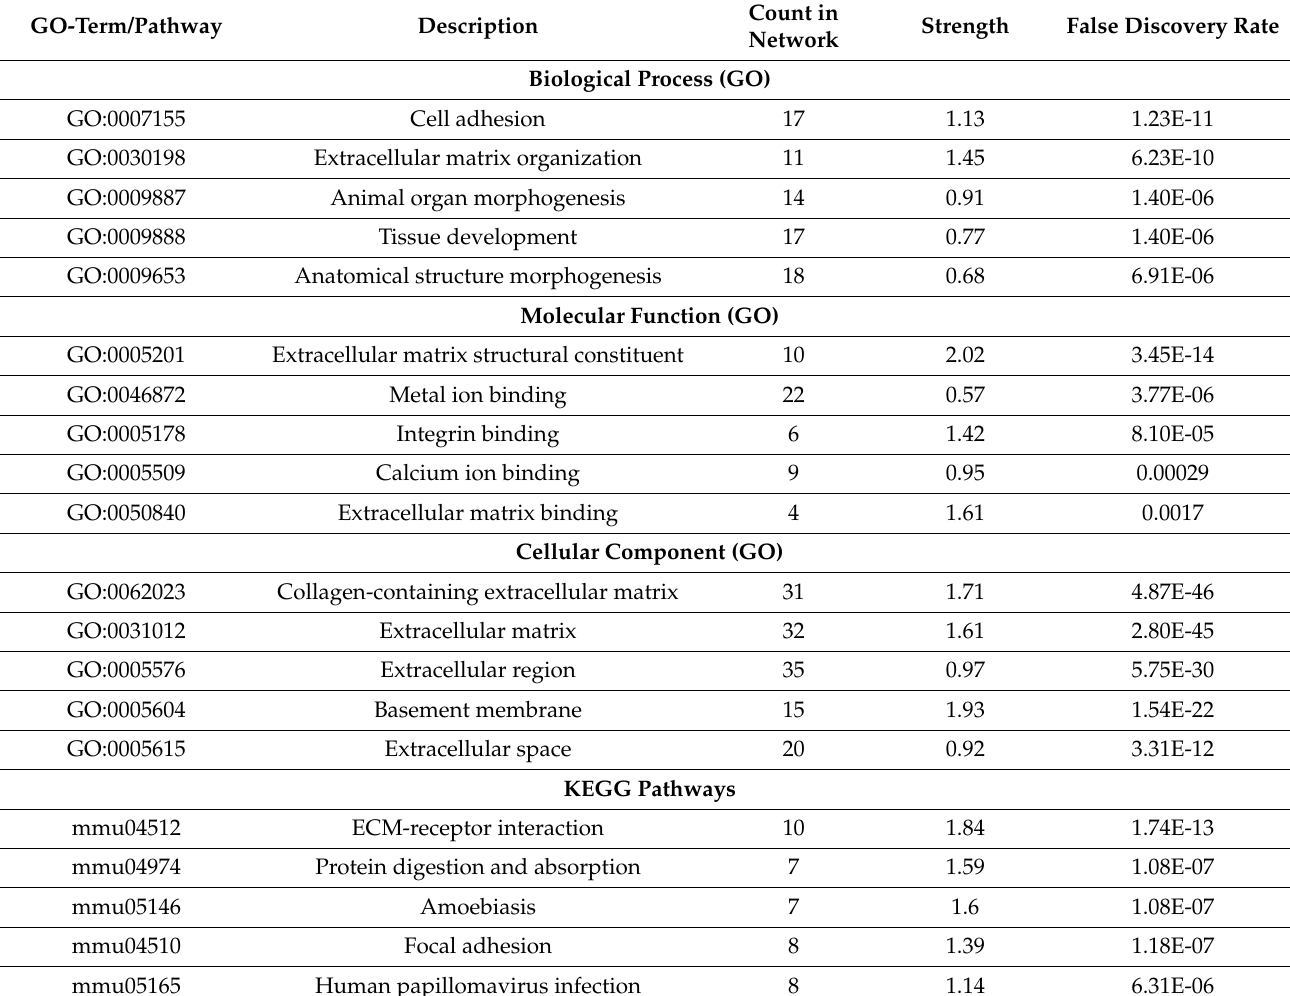
Table 2. Gene Ontology enrichment analysis for rhythmic mouse ECM and ECM-related protein targets analyzed using STRING DB